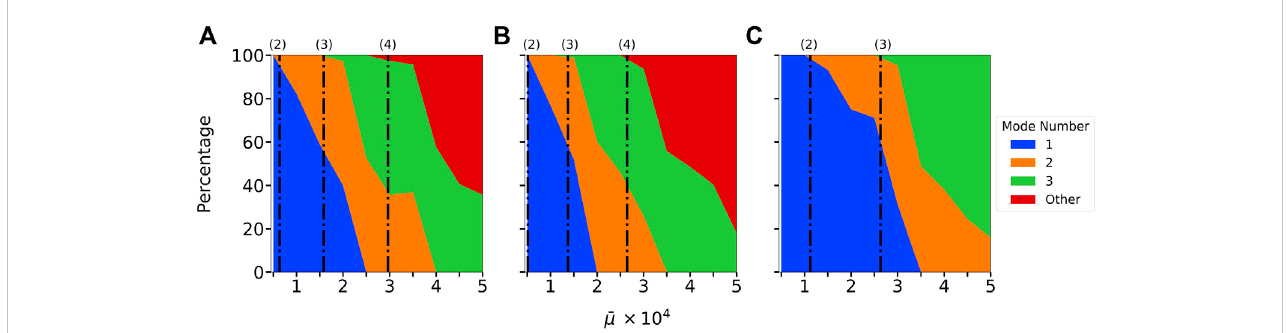
FIGURE 7 Distribution of the most unstable mode in extensional Brownian simulations in instances where the fi lament crossed the Brownian noise fl oor threshold for (A) B